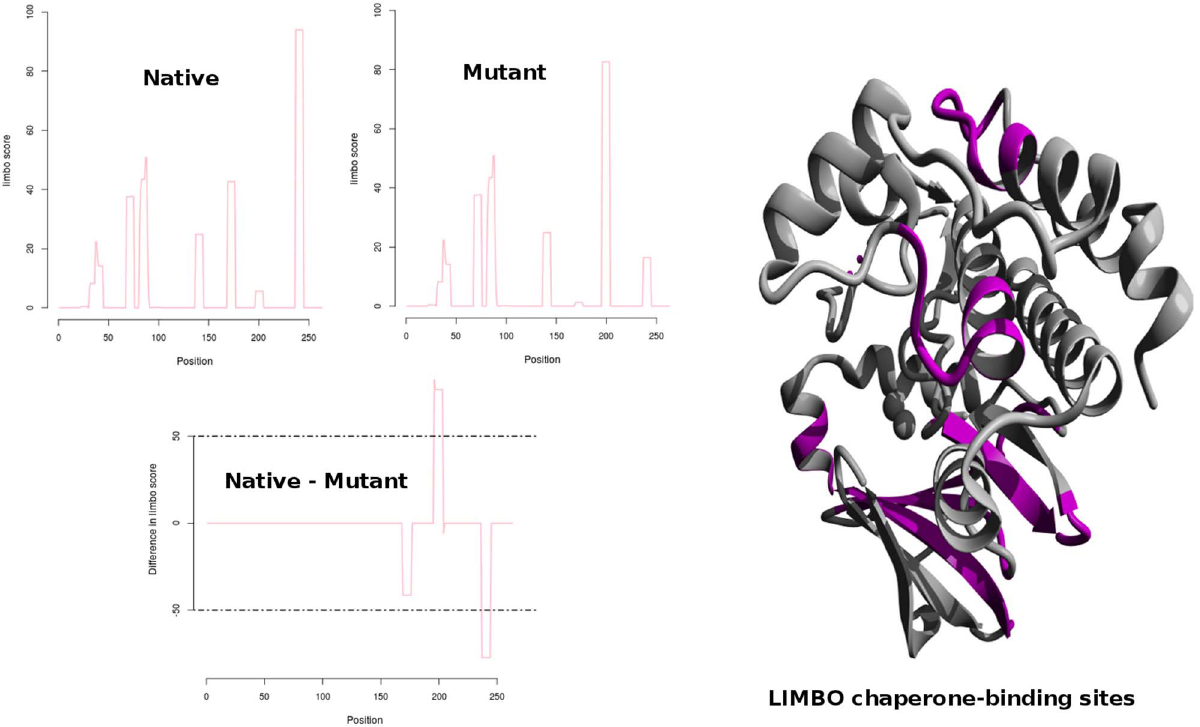
Figure 2. Profile representation of the LIMBO stretches in a) Native and b) Mutant protein. c) Difference in LIMBO chaperone binding propensity between native and mutant. d) Molecular visualisation of LIMBO chaperone-binding sites as pink colored